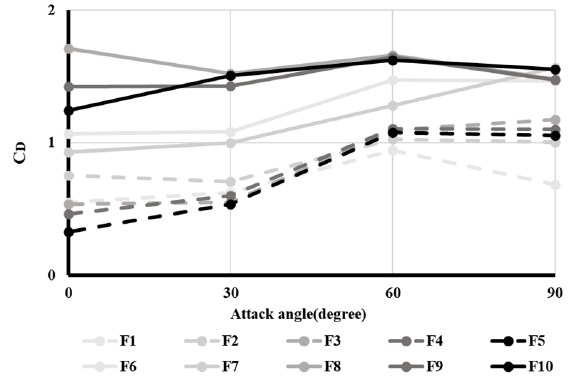
Figure 5. The relationships between the resistance coefficients (C D ) of floats (F1–F10) and their attack angles under 0.75 m/s flow conditions.